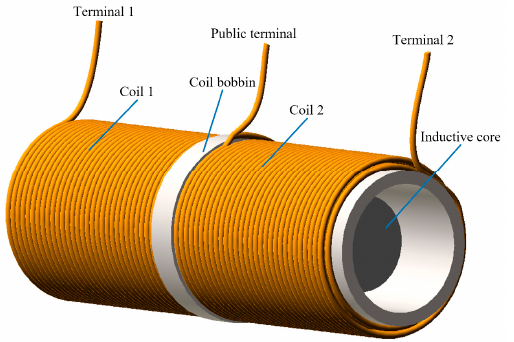
Figure 1. Structure diagram of a double ‐ coil inductive displacement transducer.